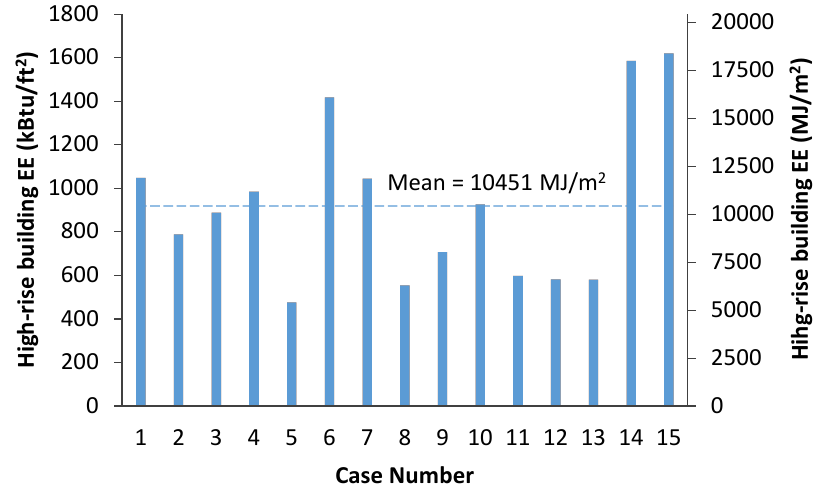
Figure 6. Embodied energy (EE) of high-rise building case studies in the literature.